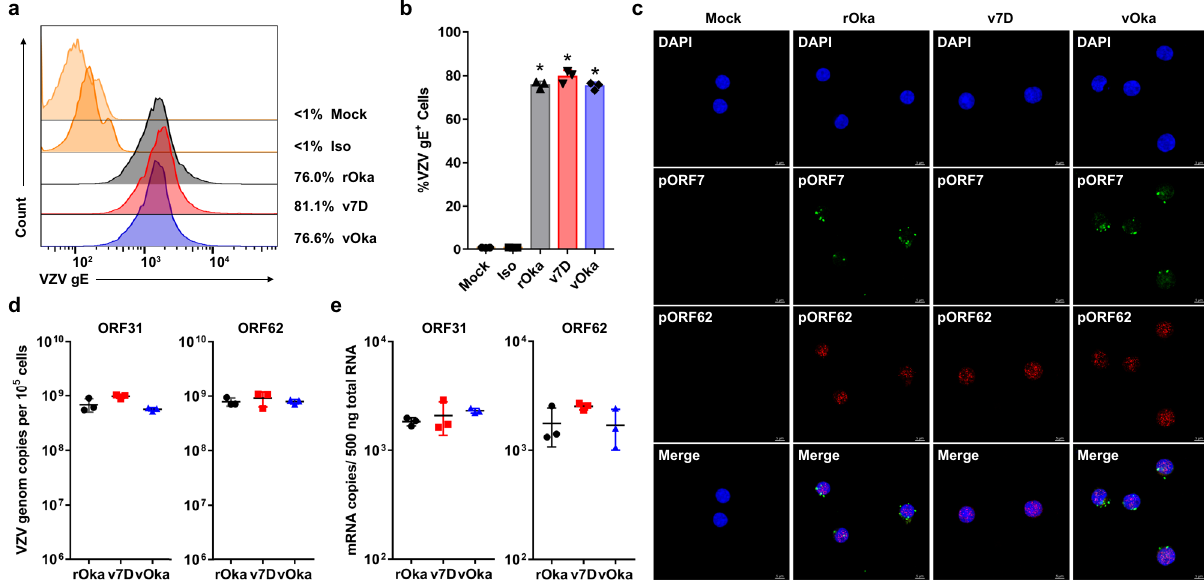
Fig. 2 v7D retains full infectivity for human PBMCs in vitro. Human PBMCs were mock-infected or infected with rOka, v7D, and vOka (MOI = 0.01), respectively. The cells were harvested at 3 dpi. a , b Representative fl ow cytometry analysis and summary of the cell-surface expression of VZV gE on PBMCs. rOka-infected PBMCs were stained with an isotype antibody (iso) as a control. Numbers on the right side of each graph in ( a ) represent the percent of VZV-gE-positive cells. Asterisks in ( b ) denote a signi fi cant difference ( P < 0.05) compared to the mock-infected controls as determined by